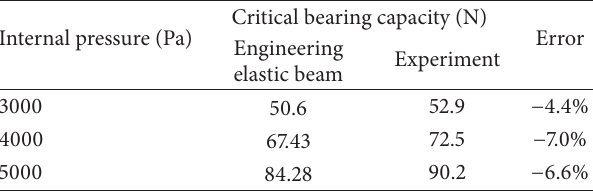
Table 1: Comparison between the results of elastic beam theory and results of